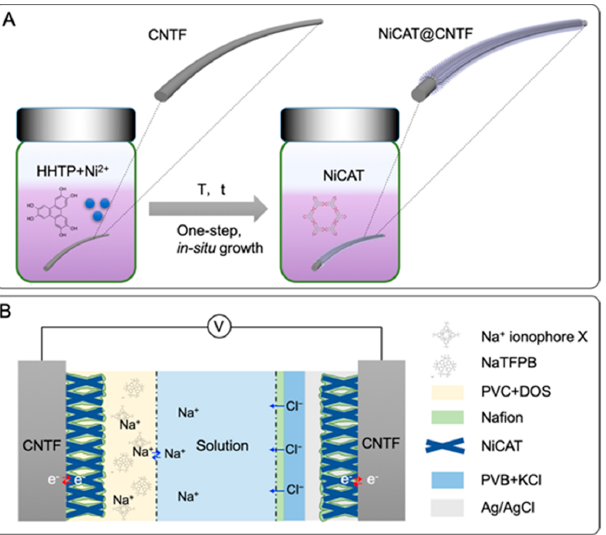
Figure 5. Schematic illustrations of the fabrication and structure of the NiCAT@CNTF-based ISE and RE [58]. ( A ) One-step in-situ growth of NiCAT on CNTF in a liquid containing the organic linker of HHTP and Ni(II). ( B ) Schematic profile of NiCAT@CNTF-based ISE and RE in an electrochemical cell. Reprinted from Ref. [58]. Copyright (2022), with permission from Elsevier.